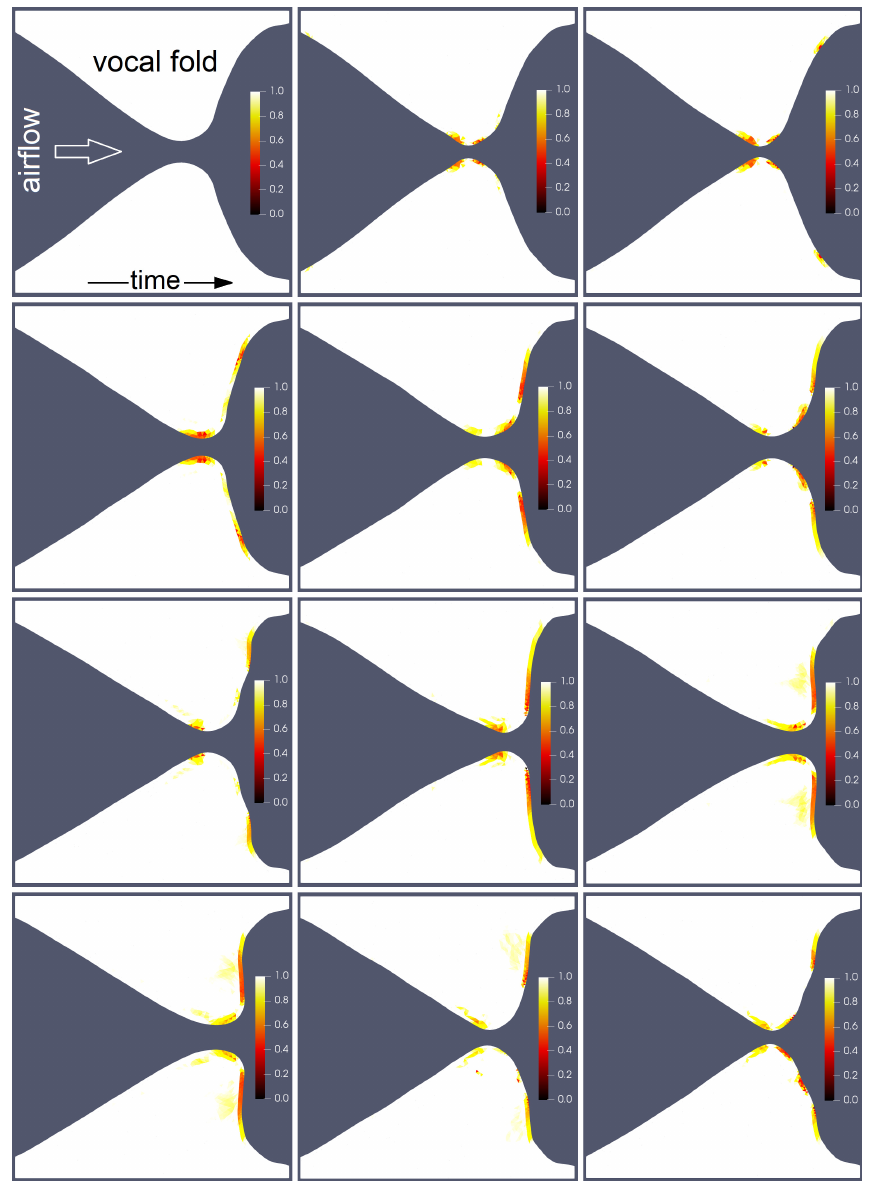
Figure 10. Visualization of the VFs vibrations and the ratios R of the norms of linear and nonlinear strain tensors at twelve time instants. Computed by the neo-Hookean model.